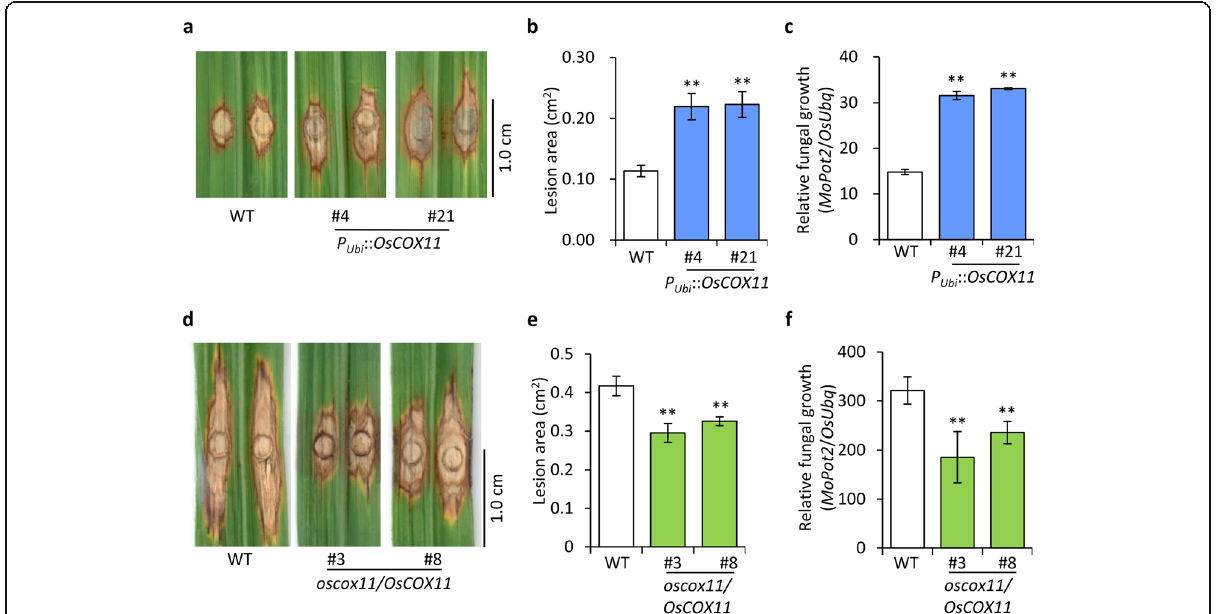
Fig. 4 OsCOX11 functions as a negative regulator of basal resistance against M. oryzae. a Disease symptoms of P Ubi ::OsCOX11 and WT plants in response to M. oryzae isolate 10 – 441. The inoculated leaves were photographed at 12 dpi. b Lesion area was measured with ImageJ software. Data are shown as the mean ± SD (** P < 0.01, n > 12). c Fungal biomass in inoculated leaves, as quantified by qPCR comparing the DNA amounts of the fungal gene MoPot2 and the rice gene OsUbq . Data are shown as mean ± SD (** P < 0.01, n > 12). d Disease symptoms of oscox11/OsCOX11 and WT plants inoculated with M. oryzae isolate 13 – 219. The leaves were photographed at 12 dpi. e Lesion area was measured with ImageJ software. Data are shown as mean ± standard error (SD) (** P < 0.01, n > 12). f Relative fungal biomass on M. oryzae -inoculated leaves, as measured by qPCR. Data are shown as mean ± SD (** P < 0.01, n >